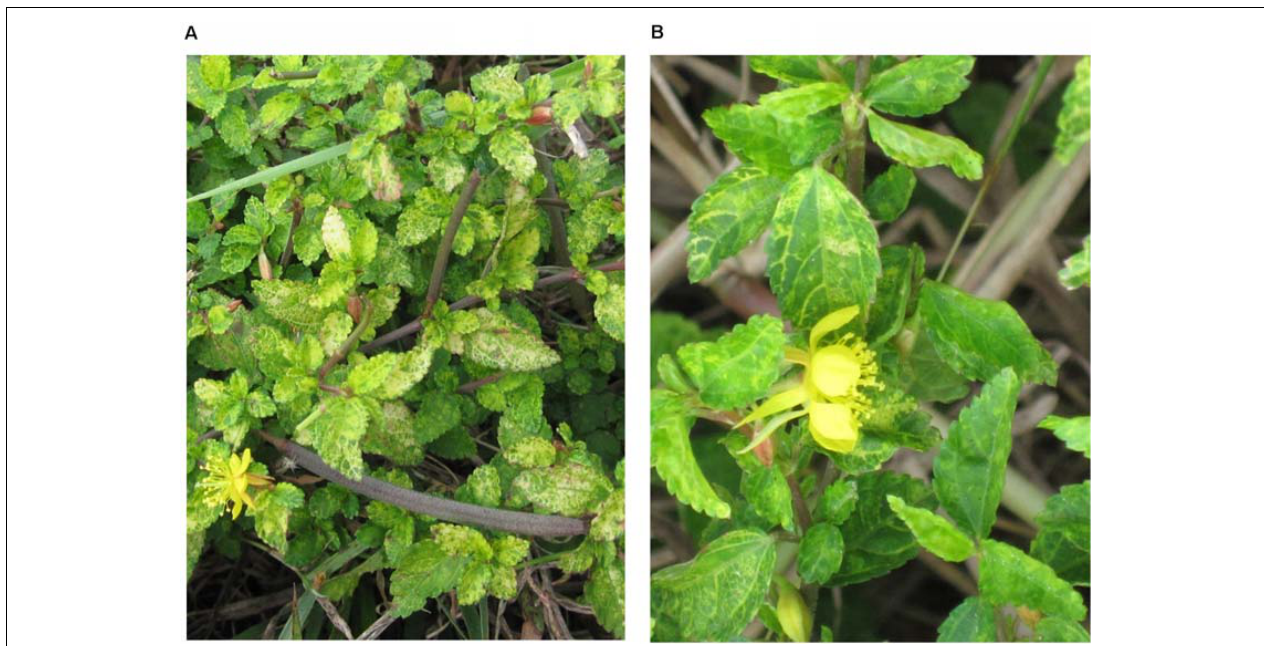
FIGURE 1 | Corchorus siliquosus plants showing vein yellowing symptoms. (A) Sample 679. (B) Sample 705.